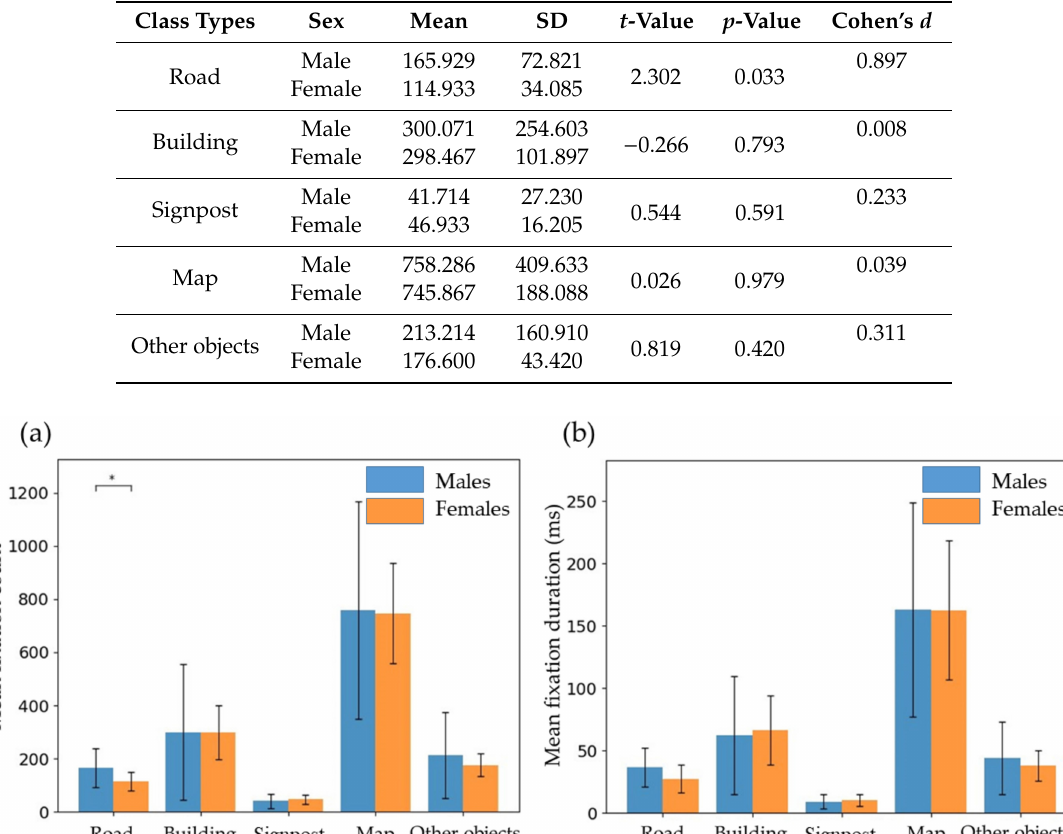
Table 3. Fixation counts of males and females.